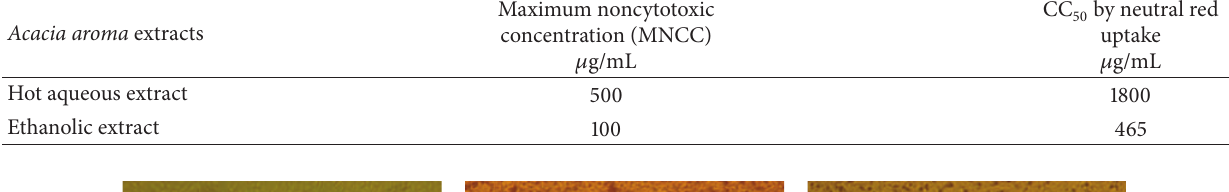
Table 1: Cytotoxicity of hot aqueous extract and ethanolic extract of Acacia aroma determined by neutral red uptake. CC concentration 50%.